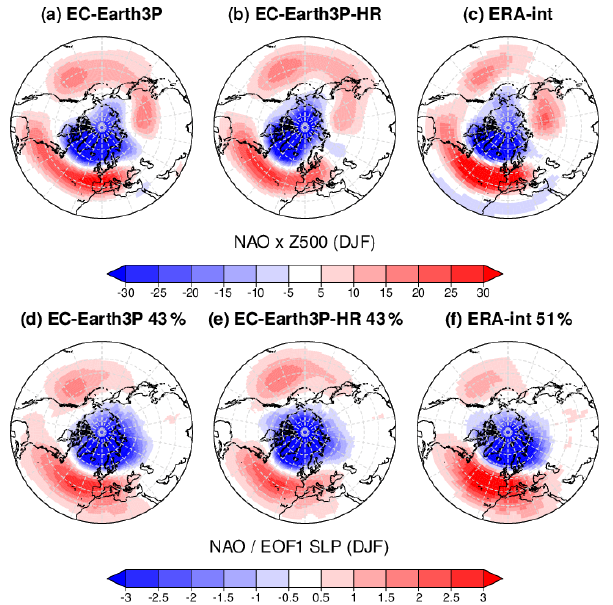
Figure 15. (a–c) Regression of 500hPa geopotential height anoma- lies from control-1950 in EC-Earth3P (a) , EC-Earth3P-HR (b) and detrended ERA-Interim (c) onto the corresponding leading princi- pal component, i.e., the NAO index. (d–f) Leading EOF of winter SLP anomalies over the North Atlantic–European region 20–90 ◦ N, 90 ◦ W–40 ◦ E, from control-1950 in EC-Earth3P (d) , EC-Earth3P- HR (e) and detrended ERA-Interim (f) ; the corresponding fraction of explained variance is indicated in the title.